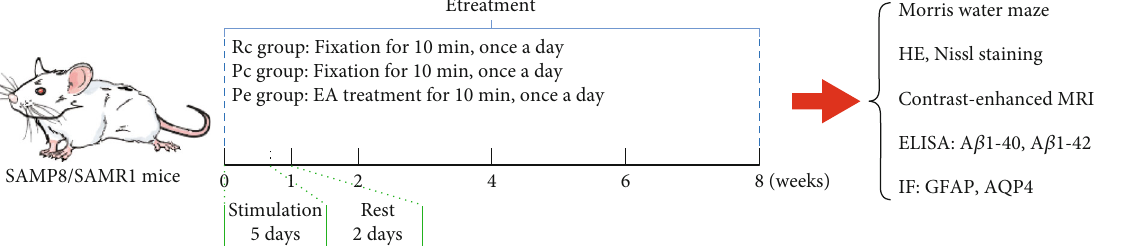
Figure 1: The process of this study.